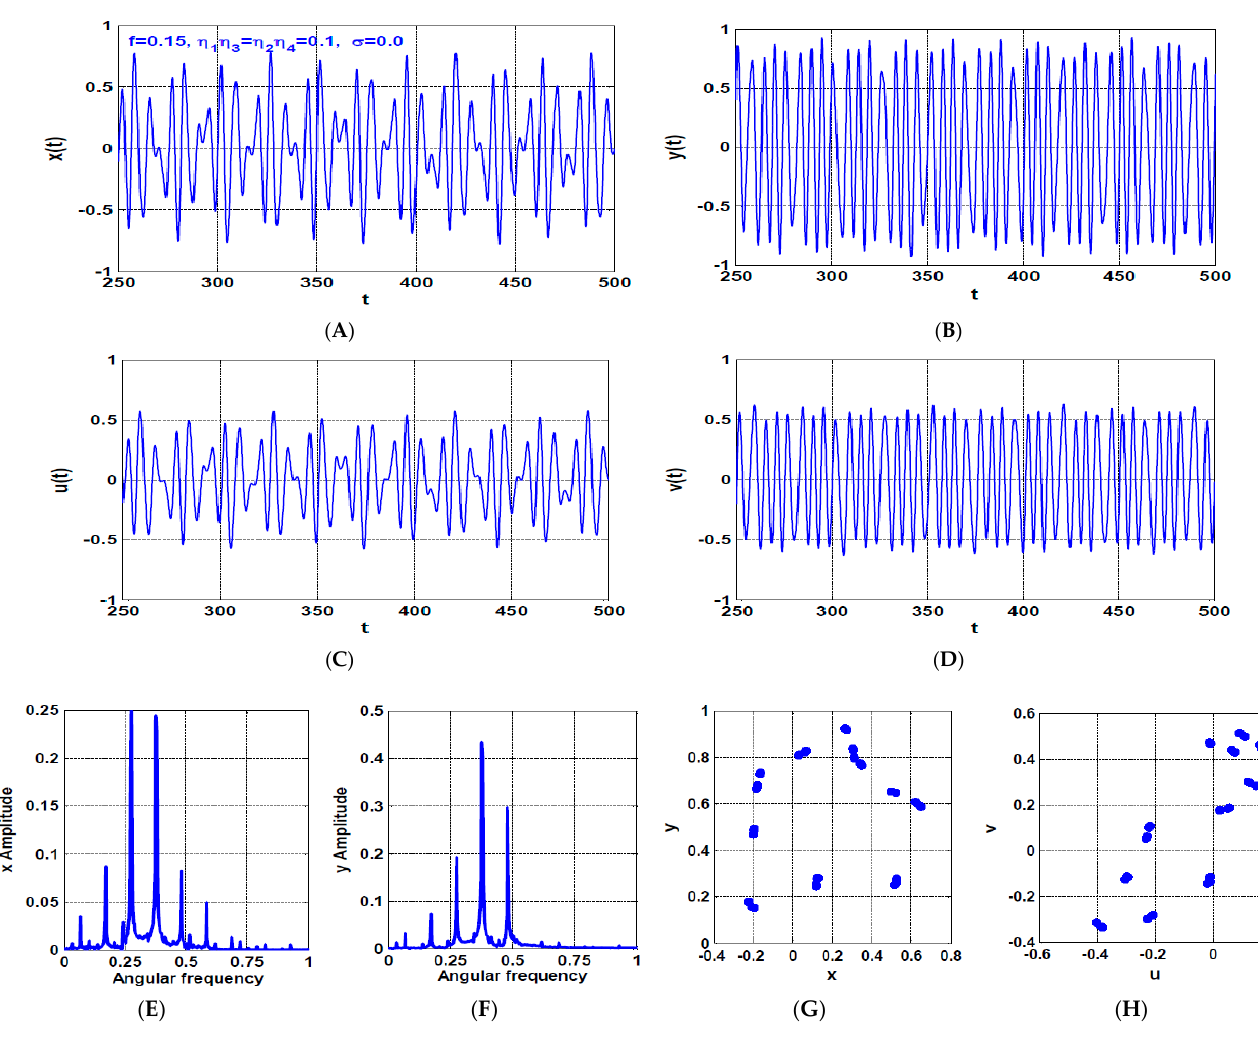
Figure 19. The rotor system steady-state time-response according to the point p 1 shown in Figure 18A (i.e., when f = 0.15, η 1 η 3 = η 2 η 4 = 0.1): ( A , B ) temporal oscillation in X and Y directions, respectively, ( C , D ) temporal oscillations of the U-IRC and V-IRC, respectively, ( E , F ) frequency spectrum, ( G , H ) the corresponding Poincaré map.